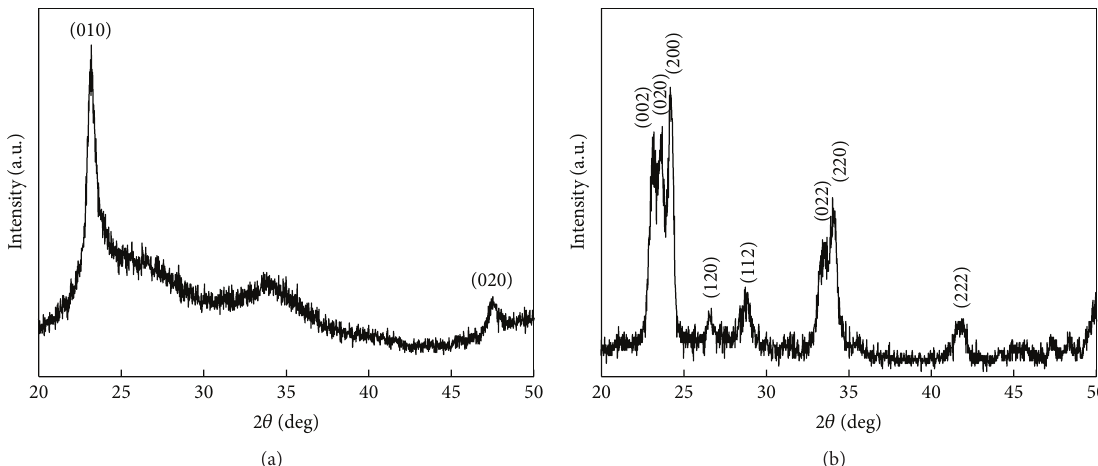
Figure 1: XRD pattern of the Cu-WO 3 samples calcined at different temperatures: (a) urchin-like Cu-doped W 18 O 49 calcined at 300 ∘ C and (b) flower-like Cu-doped WO 3 calcined at 600 ∘ C.